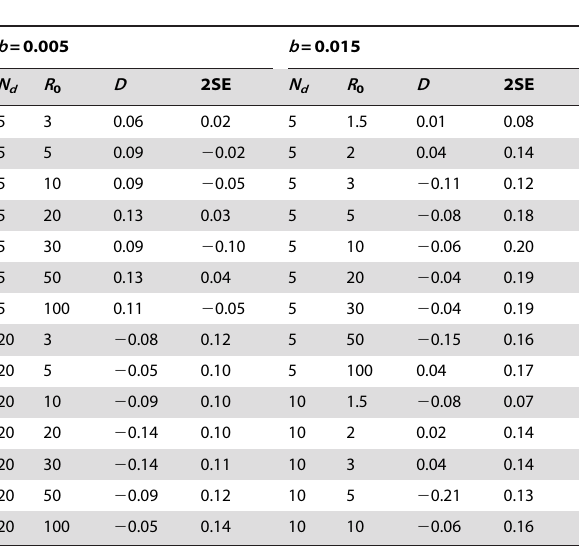
Fixed parameters were D =10000, U =0.0001 and e =0.1.